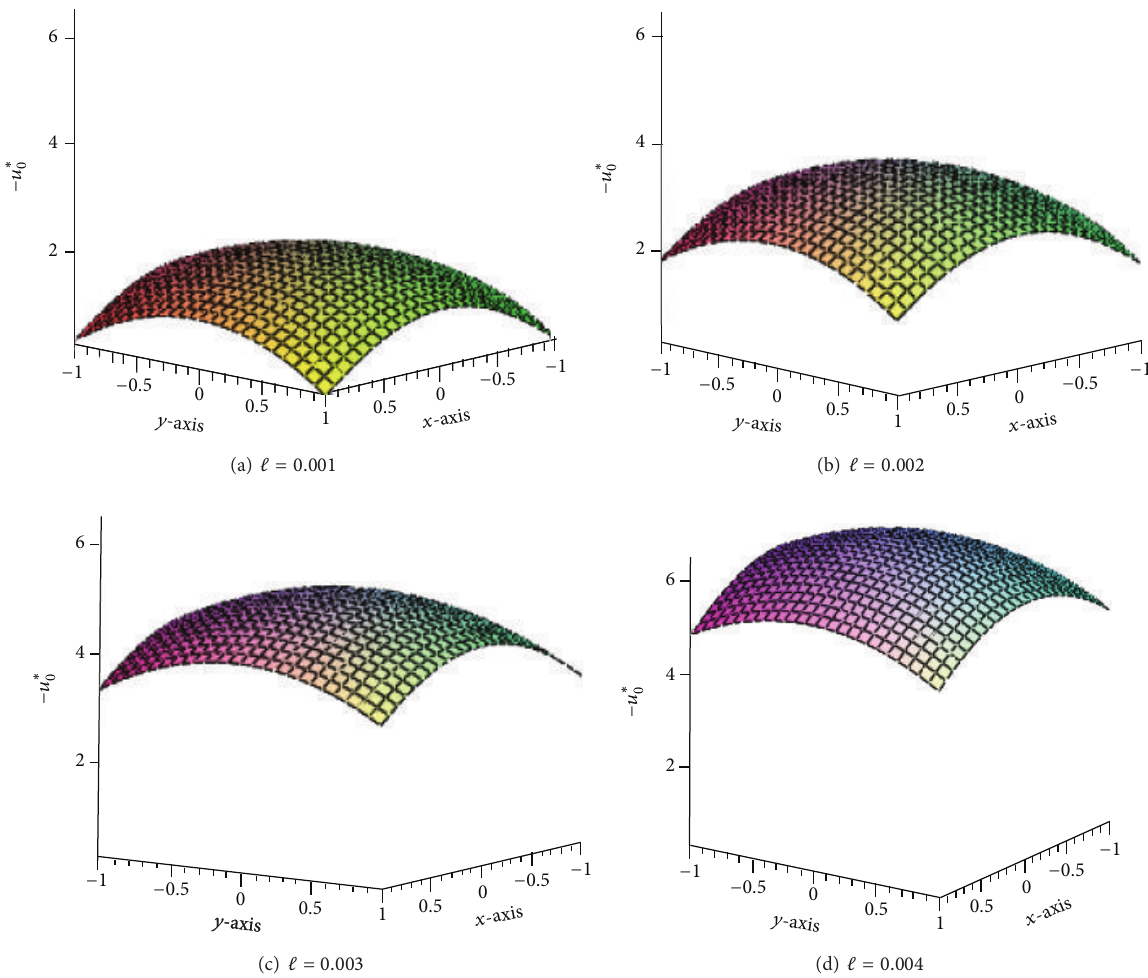
Figure 3: Axial velocity profile on the cross-section of the channel with the area of 1.0 × 10 −6 m 2 and ratio 𝜀 of 3/4 for constant pressure gradient under various values of slip lengths ℓ : (a) ℓ = 0.001 ; (b) ℓ = 0.002 ; (c) ℓ = 0.003 ; (d) ℓ = 0.004